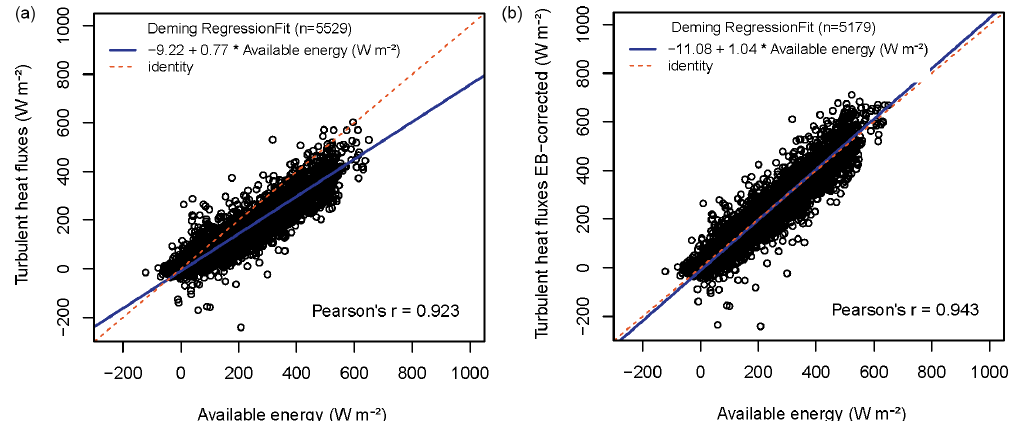
Figure 8. Results for the orthogonal regression analysis of the sum of the turbulent heat fluxes ( H + λE ) vs. the available energy ( R n − G ) as measured (a) and after application of the EBC correction (b) for the DE-Fen dataset.